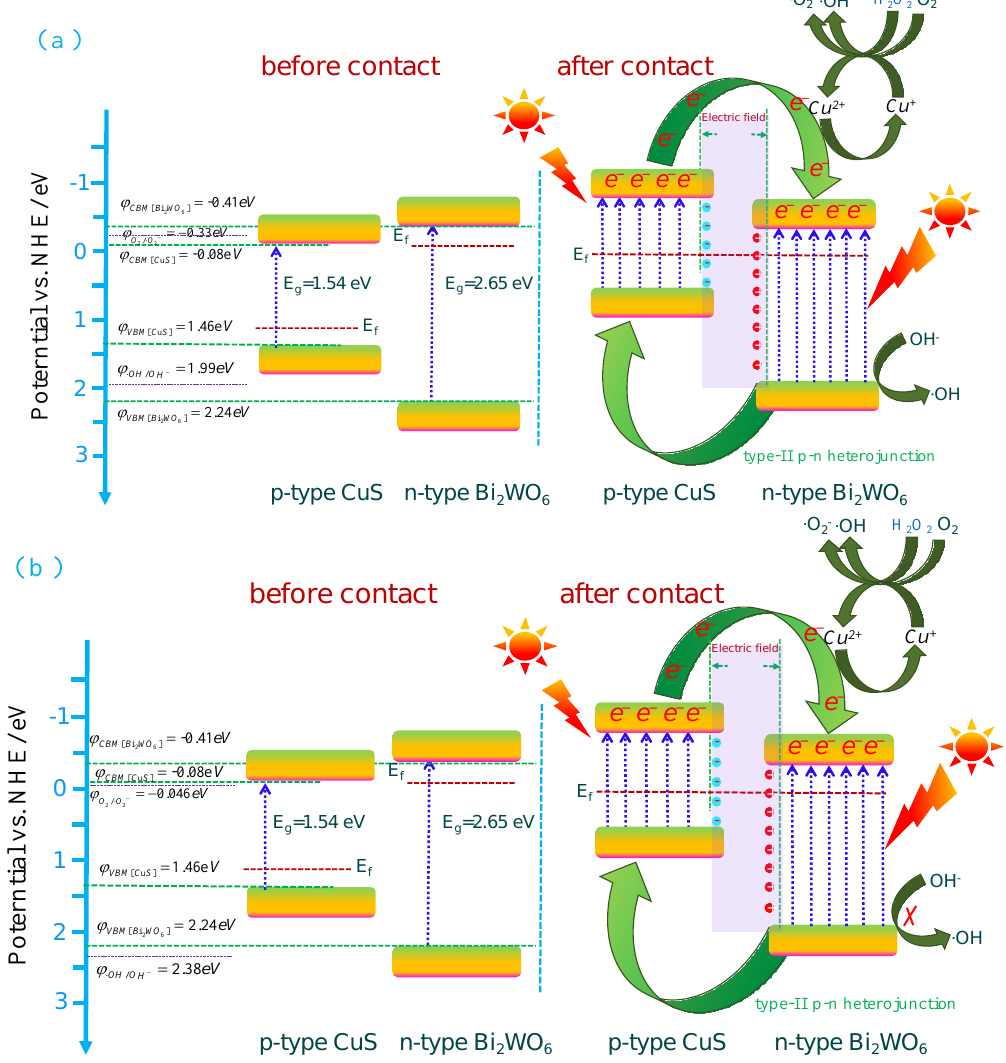
Figure 13. ( a ) The possible photocatalytic and photo-Fenton catalytic mechanism of CuS / Bi 2 WO 6 heterostructures for degradation of RhB and ( b ) TC-HCl under visible light irradiation.